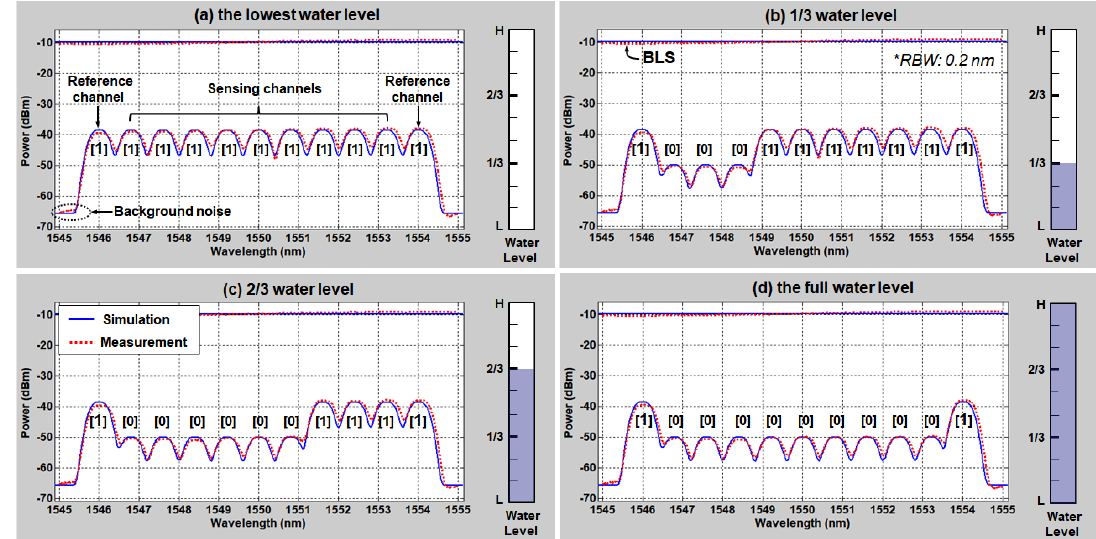
Figure 2. Simulated and measured optical spectra according to the water level at the back-to-back condition ( a ) the lowest water level, ( b ) 1 / 3 water level, ( c ) 2 / 3 water level, and ( d ) the full water level.